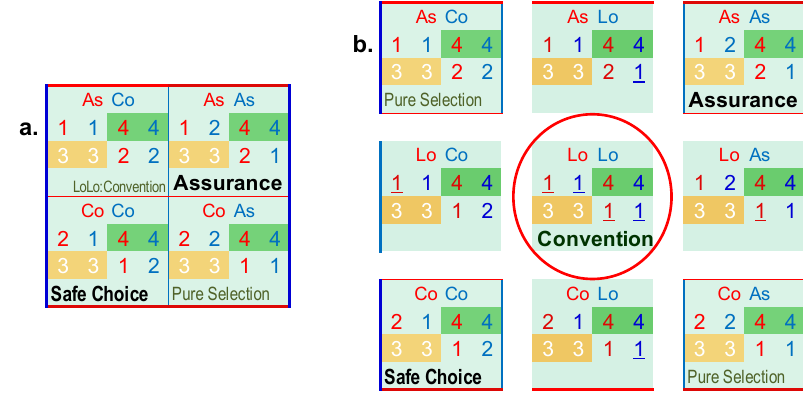
Figure A5. Tiles of games. a. Swaps in lowest payoffs (1><2) link four games to make a tile. b. Expanded tile shows games with ties between strict games (1~2). Making low ties simplifies all the games in a tile into a single game with low ties, such as Convention (LoLo).